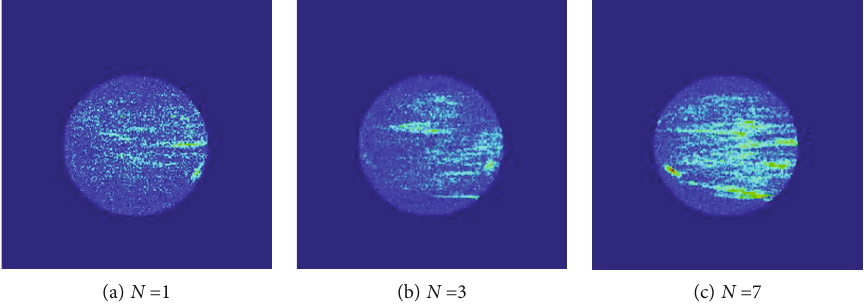
Figure 8: NMR images of residual soil under di ff erent drying – wetting cycles.